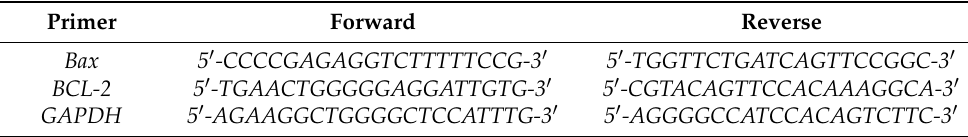
Table 1. Sequence of the primers applied for